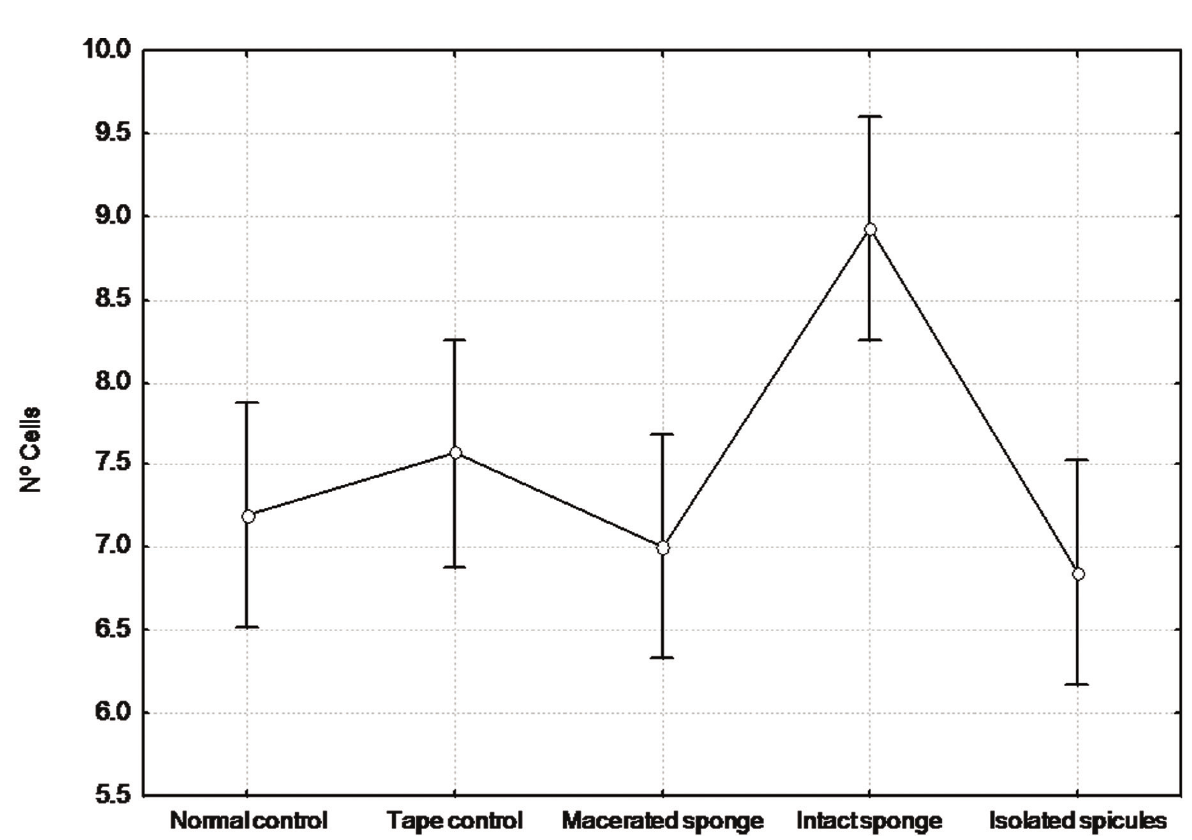
Figure 2. Graph showing the relationship between the different sponge forms and the cell-number variation, with p <